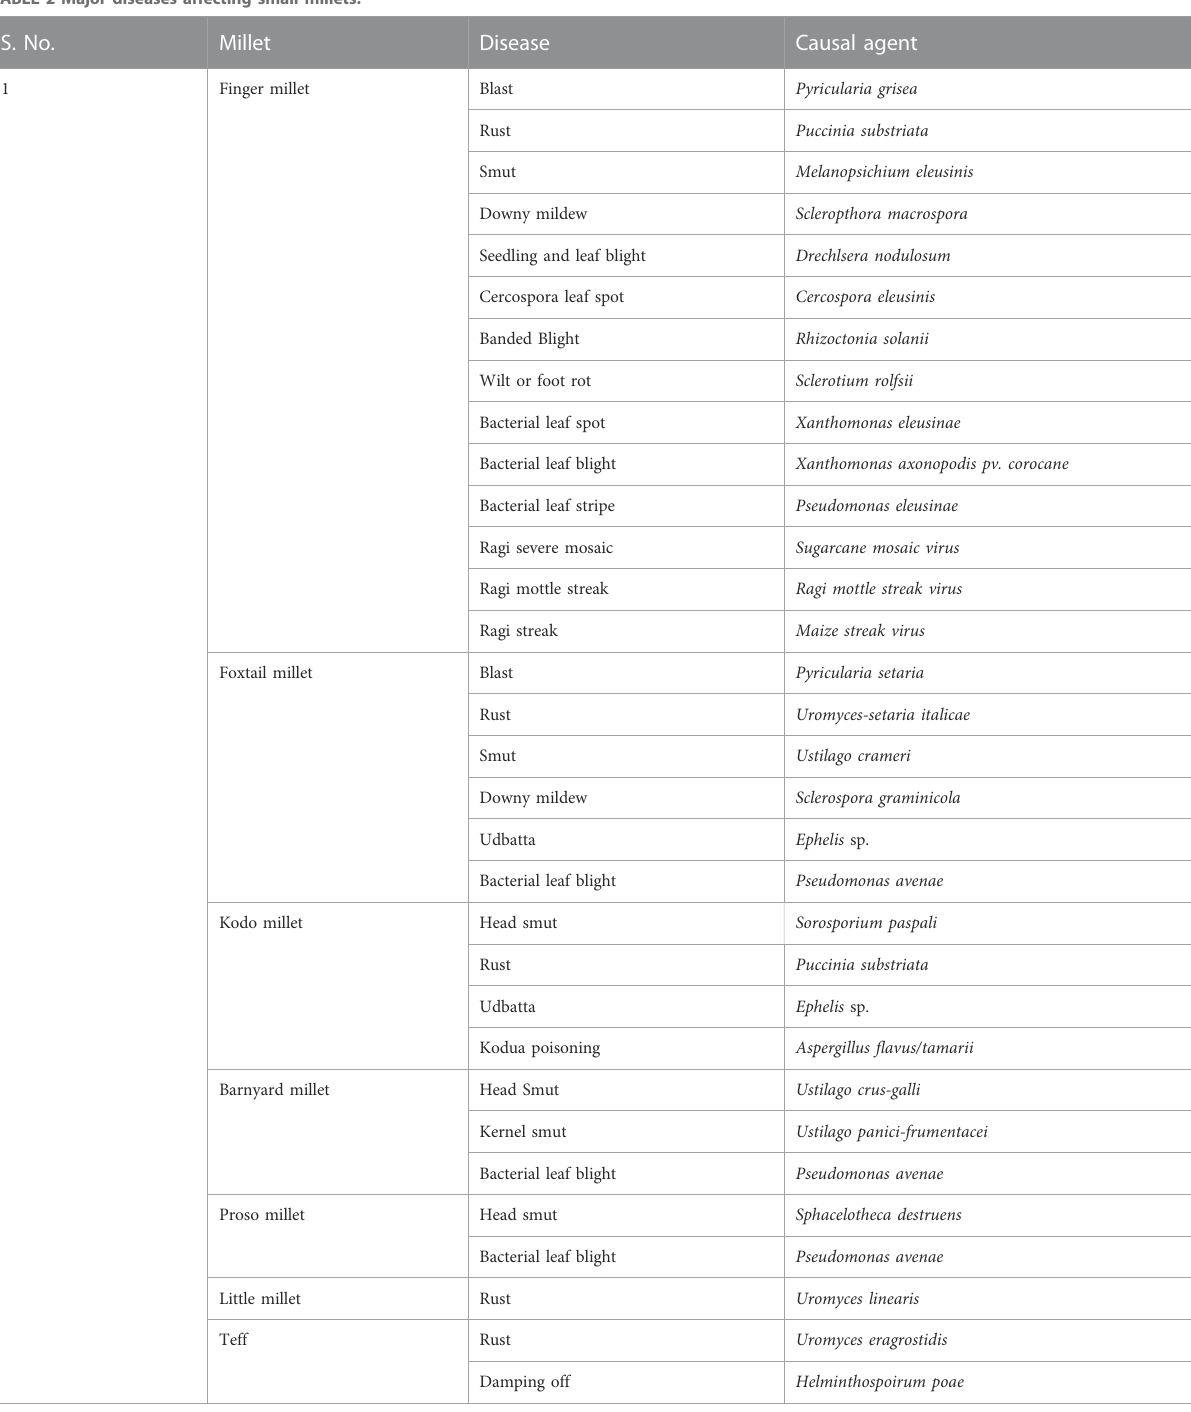
TABLE 2 Major diseases affecting small